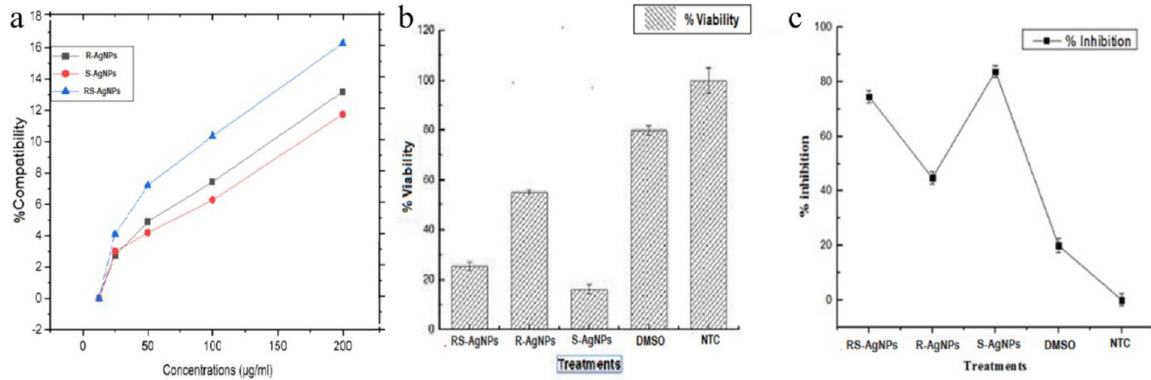
Fig 8. RBCs hemolytic assay (a) percentage viability (b) and percent inhibition (c) of cells relative to untreated control (Mean ± SD).